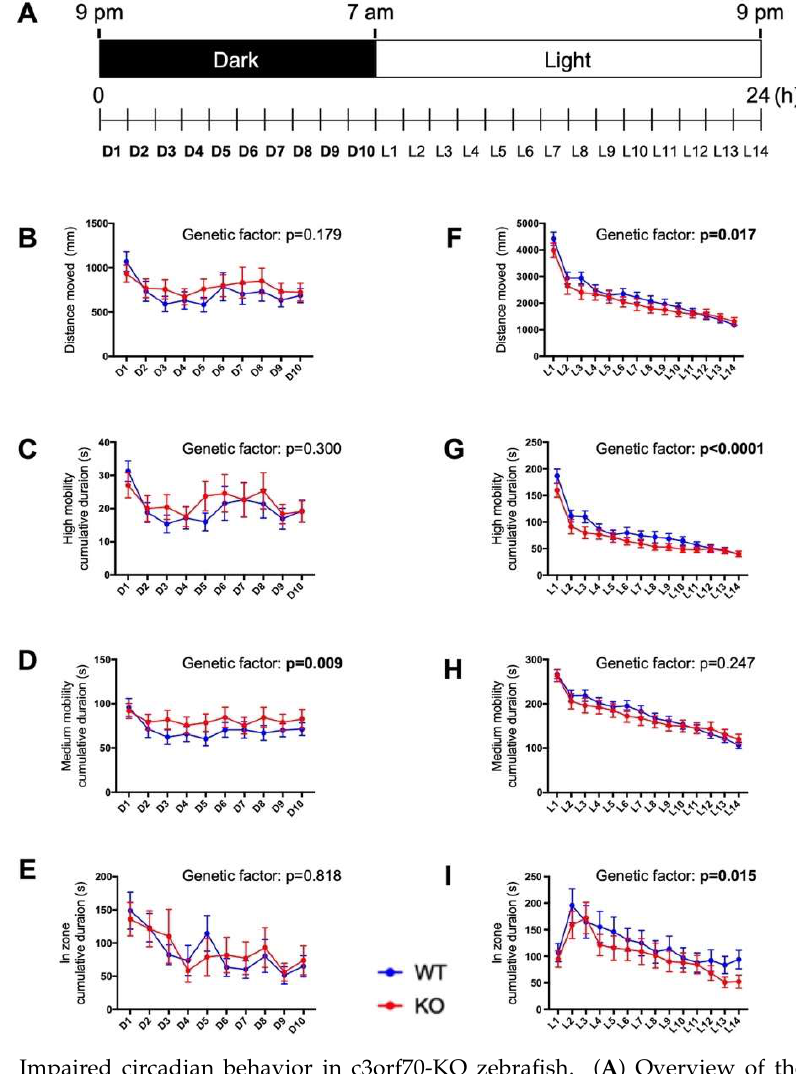
Figure 6. Impaired circadian behavior in c3orf70-KO zebrafish. ( A ) Overview of the circadian behavioral analysis. Behavior was assessed on 7 to 8 dpf using four endpoints: distance moved ( B , F ), cumulative duration at high mobility ( C , G ) and medium mobility ( D , H ), and cumulative duration in the center zone ( E , I ). Behavior during the dark and light periods is shown in ( B – E ) and ( F – I) , respectively. Data are presented as the mean ± SEM of n = 40 for WT and n = 41 for KO.